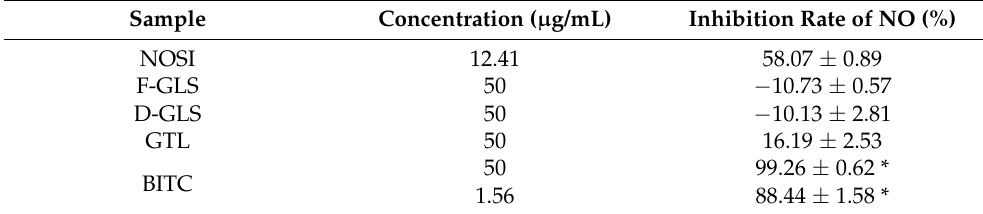
Table 4. Inhibition rate of NO production of nitric oxide synthase inhibitor (NOSI), GLS extracted from dried Maca (D-GLS), GLS extracted from fresh Maca (F-GLS), benzyl glucosinolate (GTL), and benzyl isothiocyanate